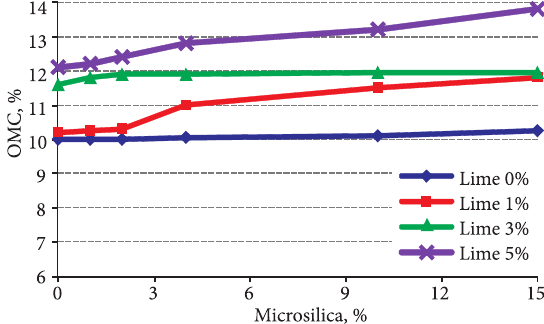
Fig. 2. Effect of adding Microsilica and Lime on the optimum moisture content